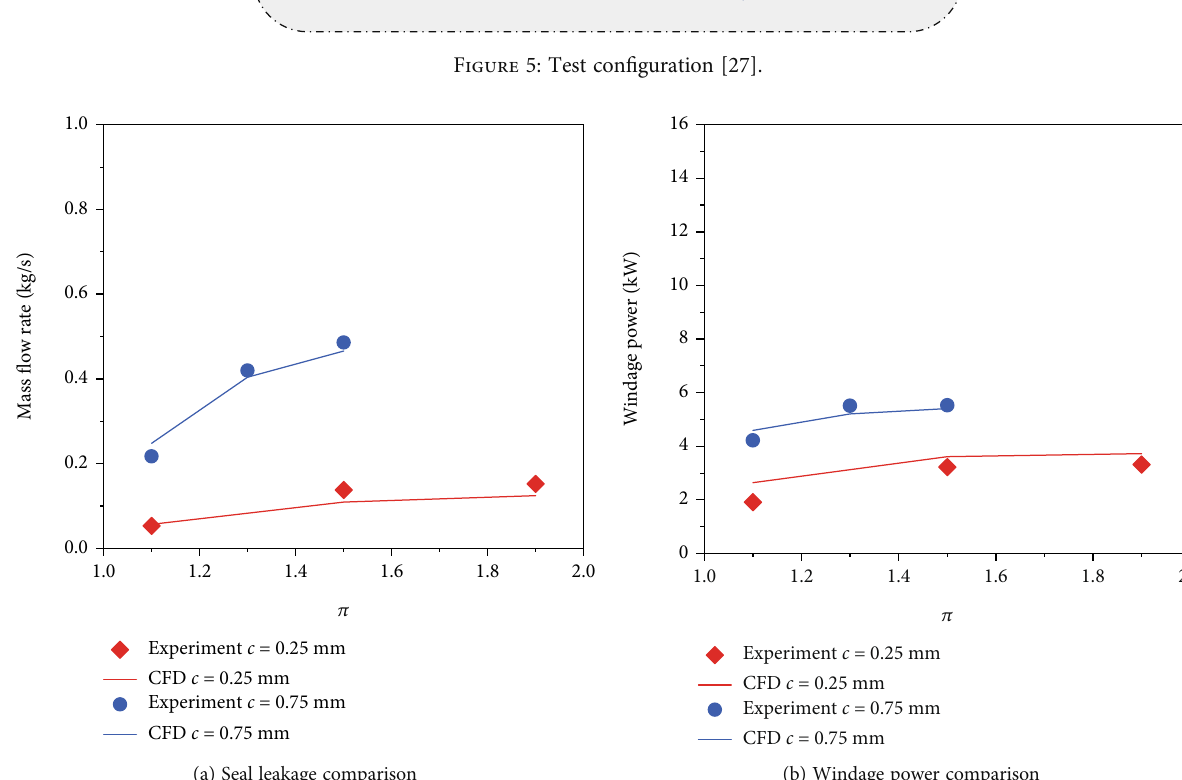
Figure 6: Validation of numerical simulation results